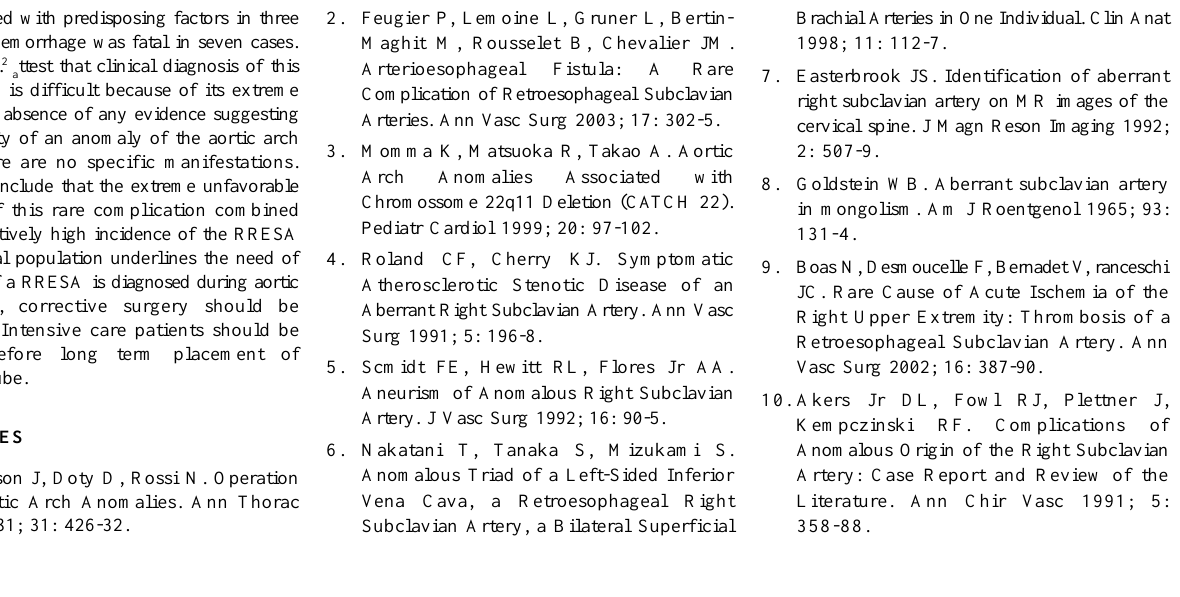
Fazan VPS, Ribeiro RA, Ribeiro JAS, Rodrigues Filho OA. Right restoesophageal subclavian artery. Acta Cir Bras [serial on line] 2003 vol 18 suppl 5. Disponível em